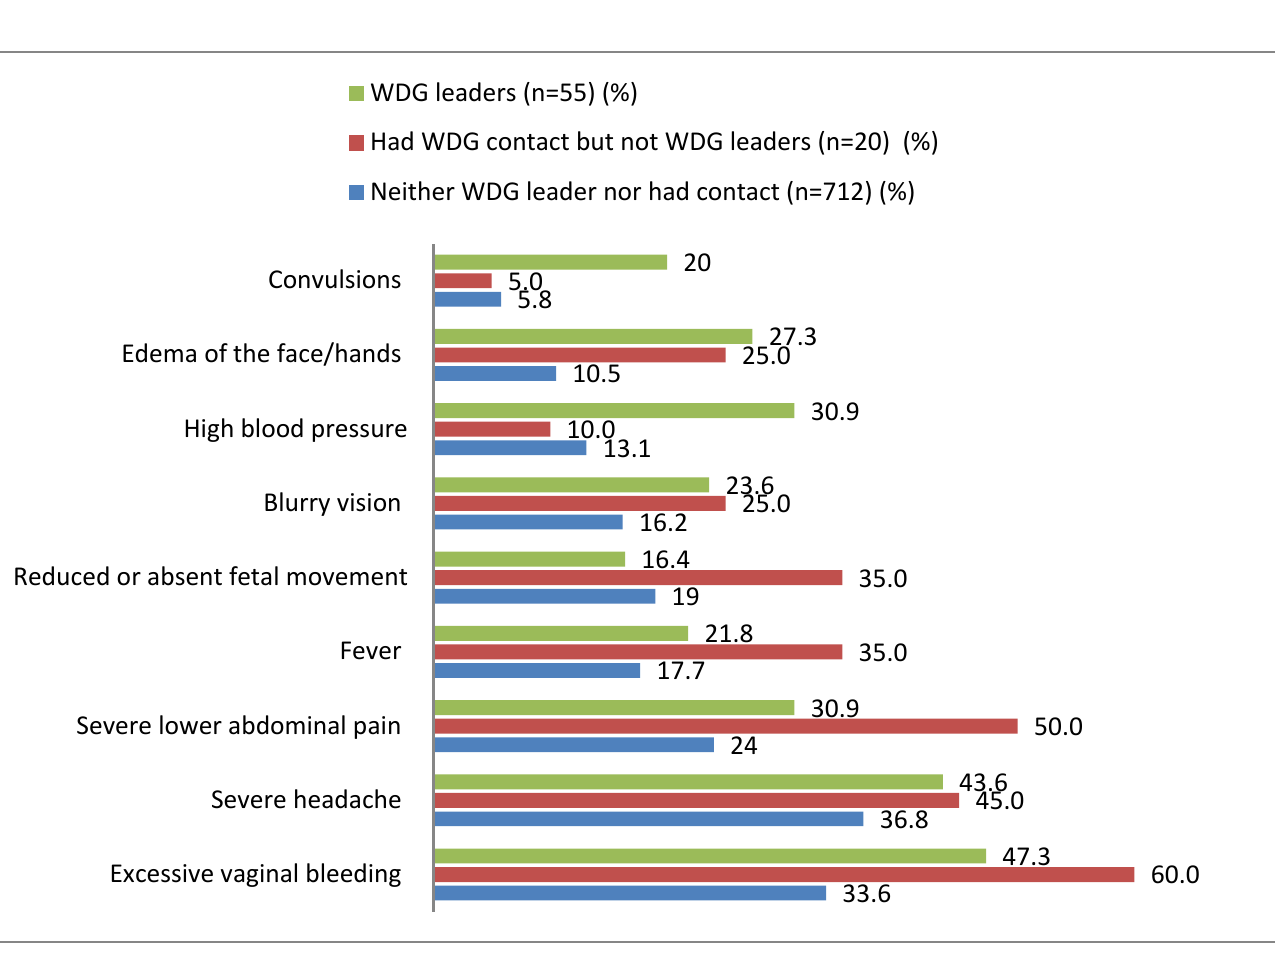
Figure 2. Knowledge of women who delivered last year on pregnancy danger signs by level of contact to the WDG, Ethiopia, 2018/19. WDG = Women’s development group. 3.3. Factors Associated with Antenatal Care, Facility Delivery, and Postnatal Care